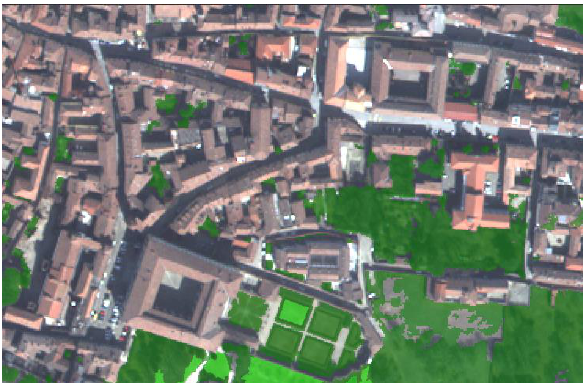
Figure 15. Same area that was segmented before being classified.